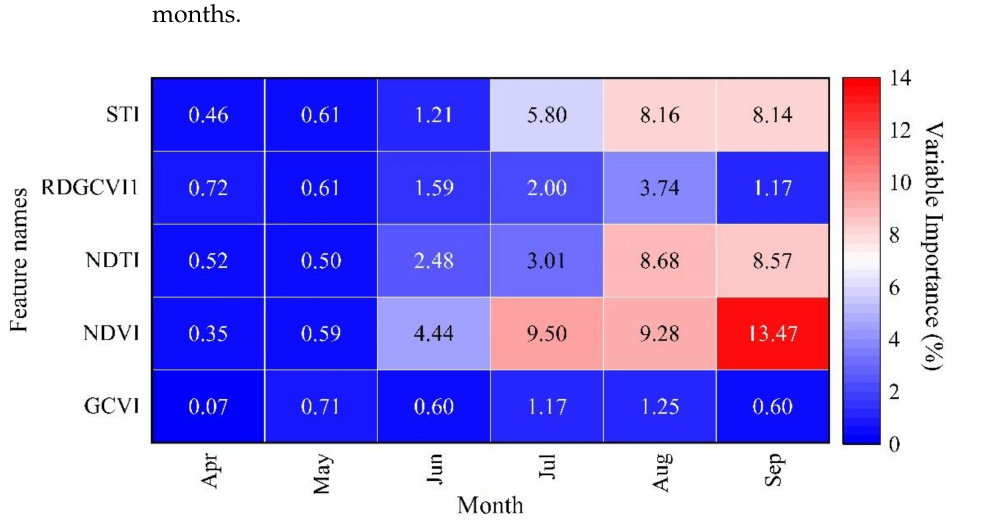
Figure 4. The importance of 30 input indicators in vegetation extraction. Note that the values of importance of variables have been normalized. The change from blue to red indicates the increasing trend of the importance of